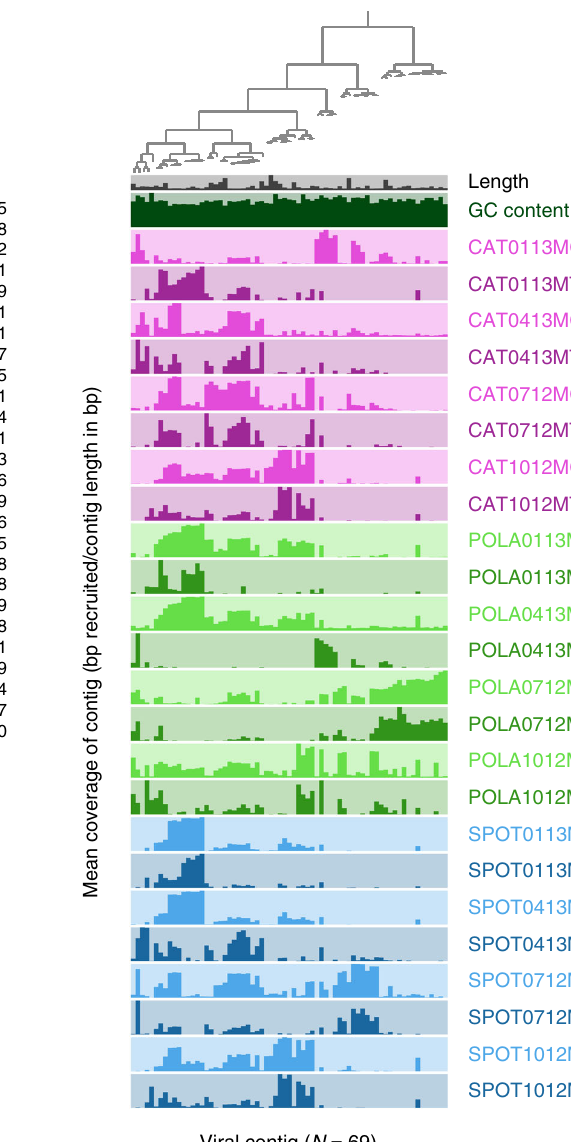
Fig. 1 Dynamics of active infections over seasons and sites. Mean coverage, as a proxy of relative abundance, of 69 viral contigs across three sites (Port of LA — POLA, San Pedro Ocean Time-series — SPOT and Two Harbors — CAT) and four seasons (July 2012, October 2012, January 2013, and April 2013) in metagenomes (MG) and metatranscriptomes (MT). Each column represents one contig and each row represents one sample. The bar heights are relative to the highest log-transformed mean coverage within each sample, detailed in the legend column Max. Mean coverage, based on bowtie2 mapping, was calculated excluding contig positions whose coverage depth was in the top 25% of coverage, as they may be biased by non-speci fi c recruitment localized to short, highly conserved portions of the contig (Supplementary Figure 3). The dendrogram denotes hierarchical clustering of the contigs by abundance